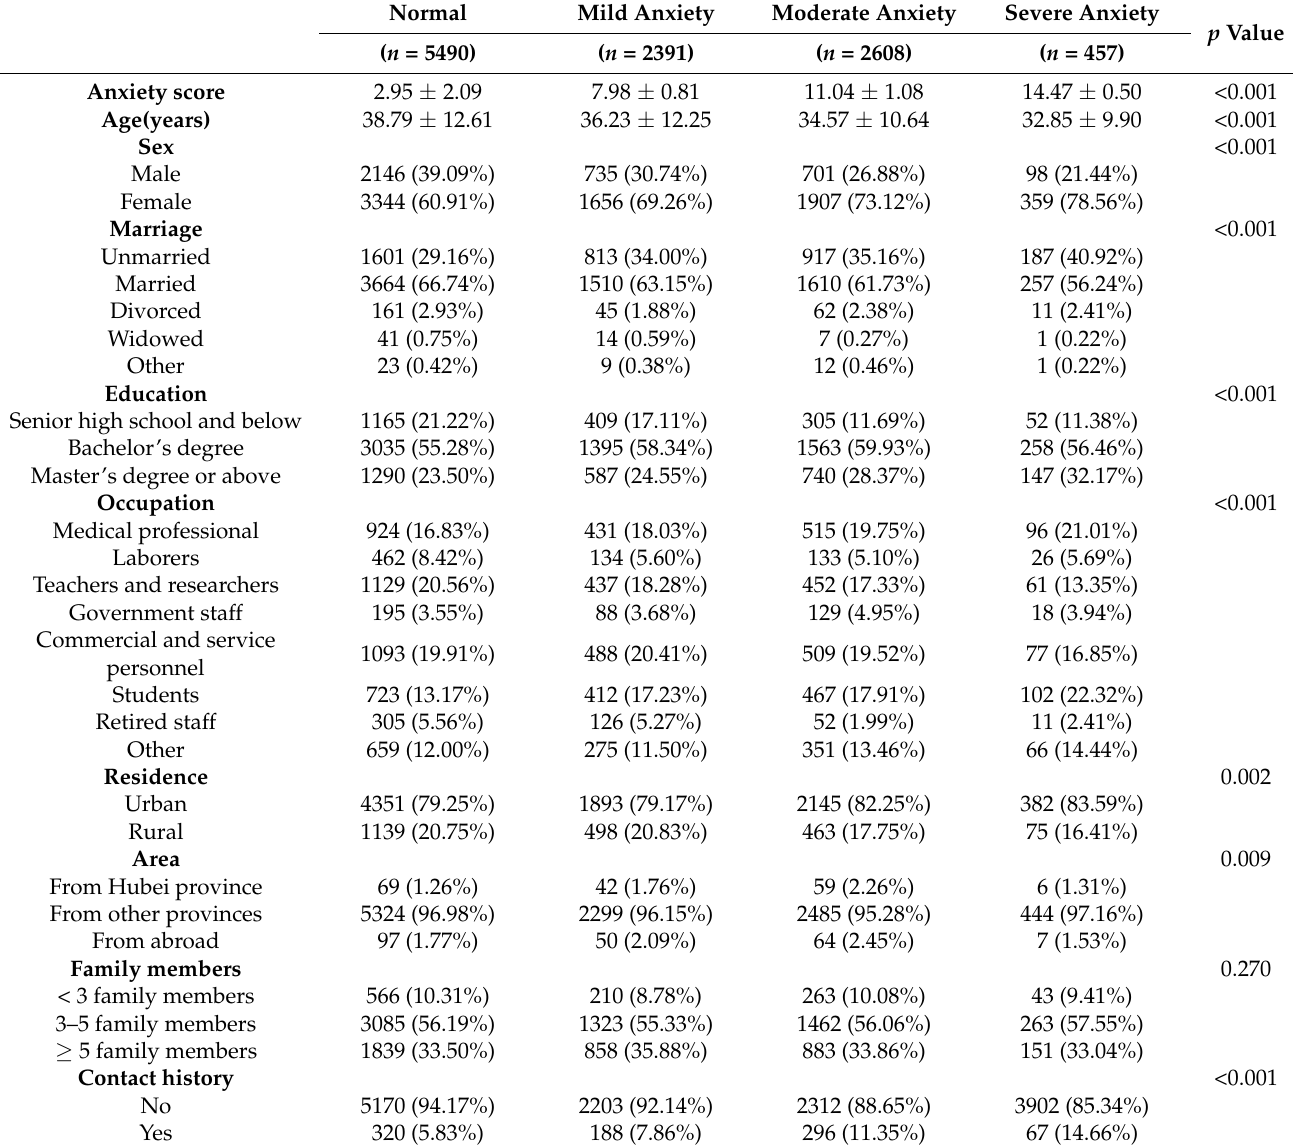
Table 1. Baseline characteristics of people by anxiety score